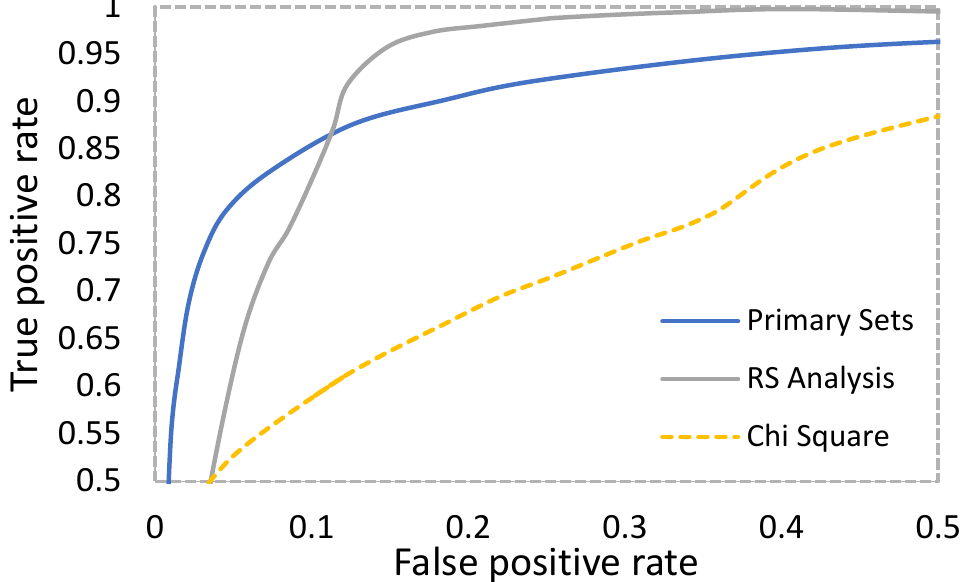
Figure 14. Security test using StegoExpose on stego images and original images.